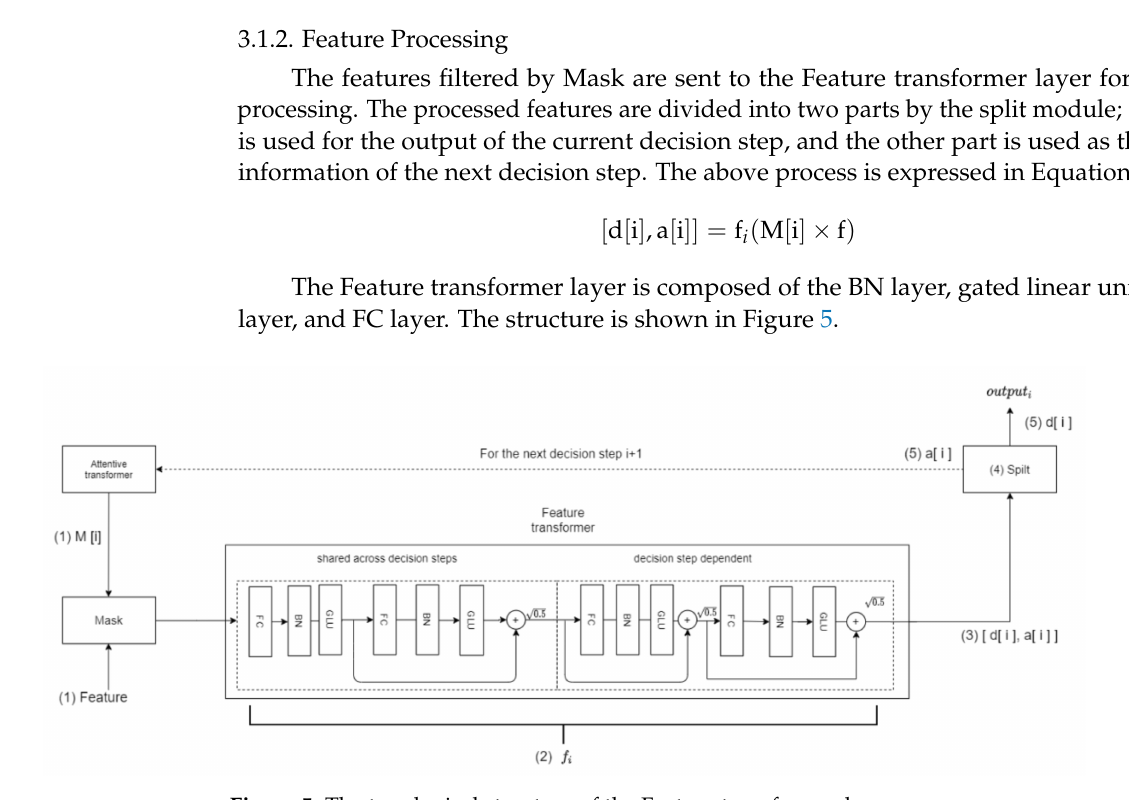
Figure 5. The topological structure of the Feature transformer layer.